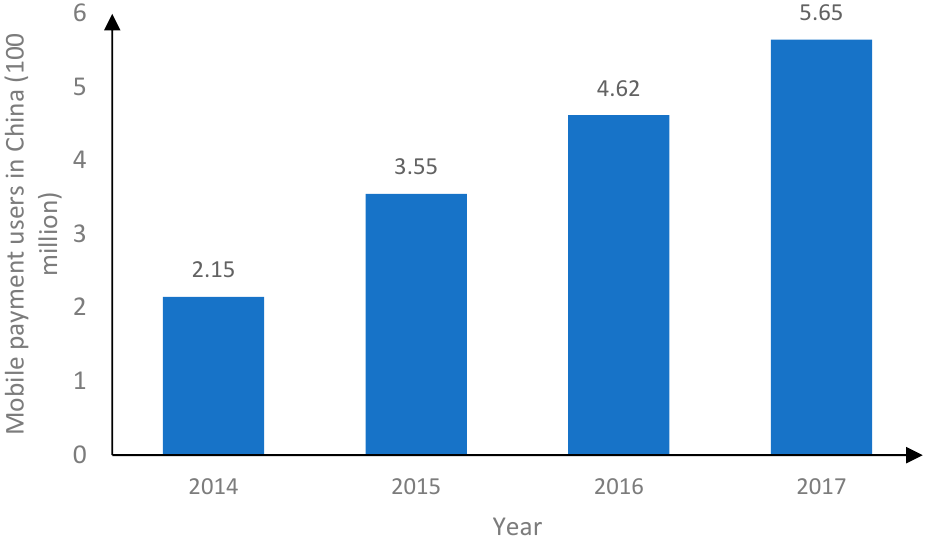
Figure 2. The number of users of China mobile payment (Data source: The People’s Bank of China).